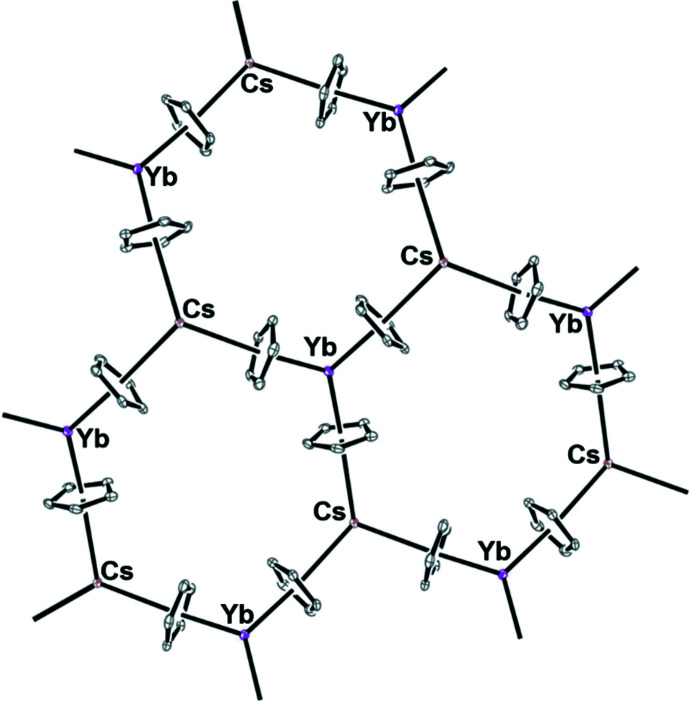
Top view of the extended structure of [(THF)Cs(μ-η5:η5-Cp′)3Yb]n, 1, with the SiMe3 substituent of the C5H4SiMe3 group and the THF attached to Cs removed for clarity.